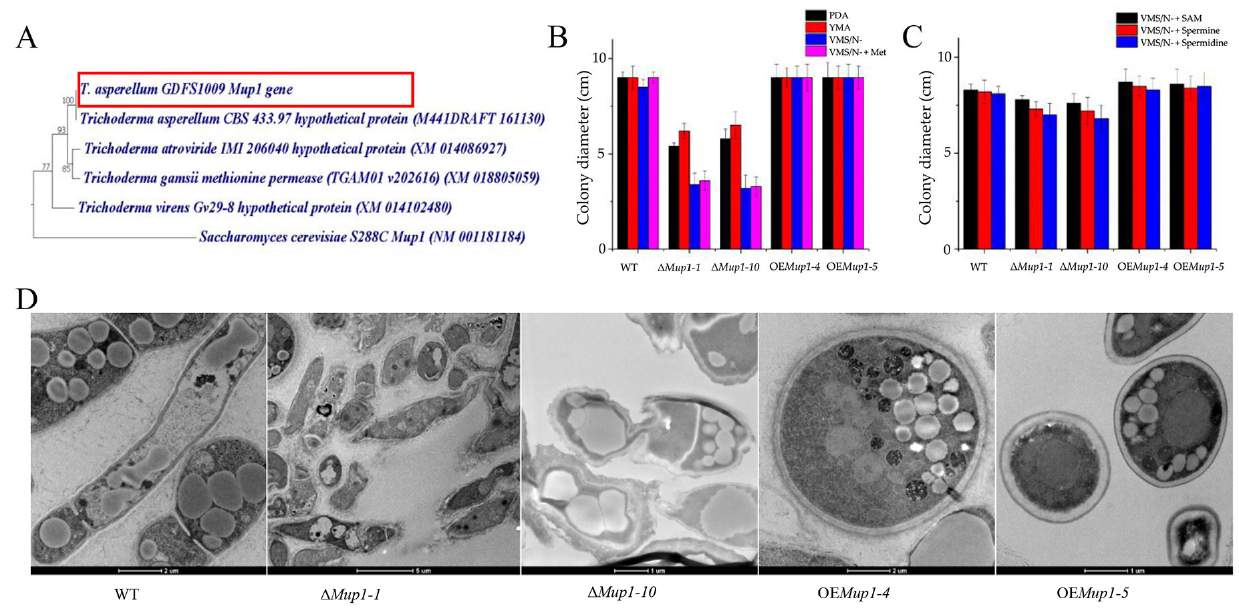
Figure 3. Phylogenetic tree analysis of MUP1 and its role in the growth and morphogenesis of T. asperellum GDFS 1009. ( A ) Dendrogram of the MUP1 gene family proteins. ( B ) Growth rate of WT and mutants in the different mediums with and without nitrogen source. ( C ) Growth of WT and mutants in the medium supplemented with the methionine metabolites. ( D ) Transmission electron microscopy morphology of WT and mutants, where ∆ Mup1–1 , ∆ Mup1–10 exhibit mycelial morphology due to the absence of sporulation, whereas OE Mup1–4 and OE Mup1–5 exhibit cell wall integrity of spores. PDA, potato dextrose agar; YMA, yeast extract molasses agar; VMS/N − , Vogel minimal salt medium (VMS) without ammonium sulfate (VMS/N −